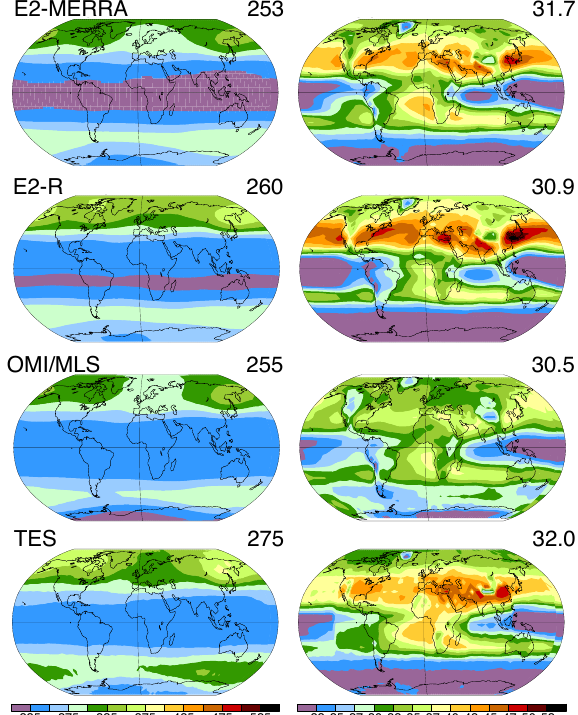
Fig. 5. Annual average stratospheric (left panels) and tropospheric (right panels) ozone column (DU) in the indicated models and observations. OMI/MLS observations are from October 2004 to December 2010, model values are 2005–2009, and TES observa- tions are from 2005–2009. Global mean values are given in the upper right of each panel. The tropopause is the NCEP value for OMI/MLS, and one model level below NCEP for the models and